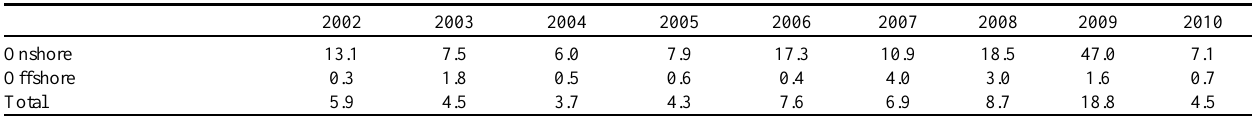
Table 4 . Quantity of oil spilled onshore and offshore per unit of hydrocarbon production (tonnes per million tonnes),